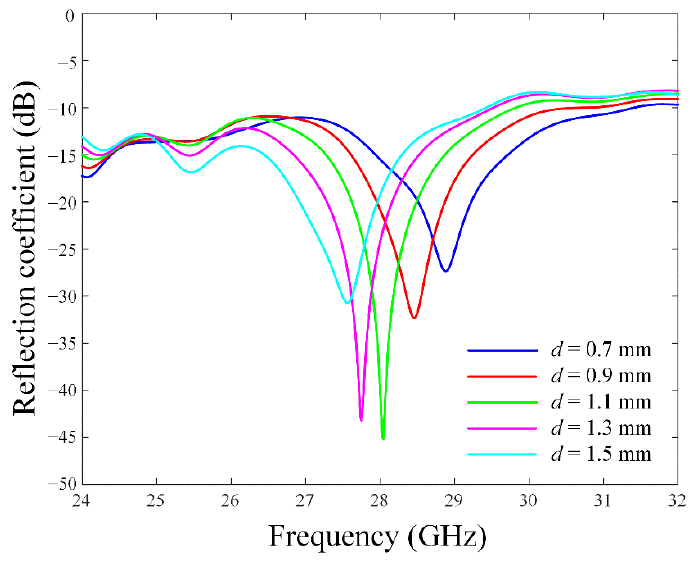
Figure 2. Reflection coefficients in accordance with the parameter d .